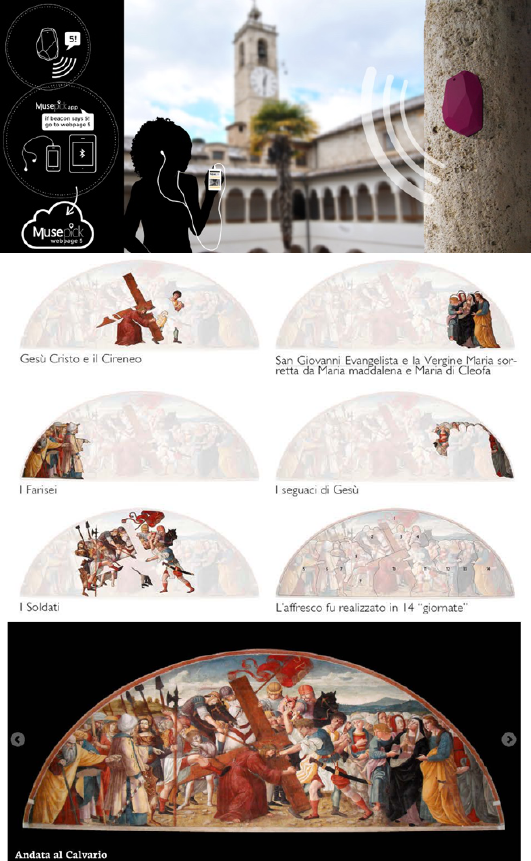
Figure 16. Beacon applications to illustrate the fresco